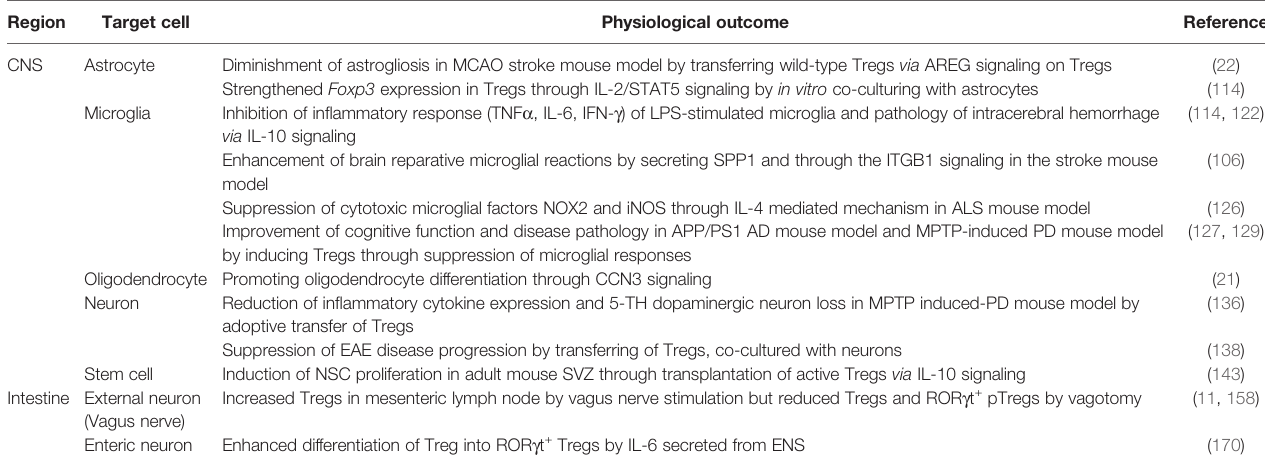
TABLE 1 | Interaction of Tregs with tissue-resident cells and its physiological outcomes in the CNS and the intestine. Region Target